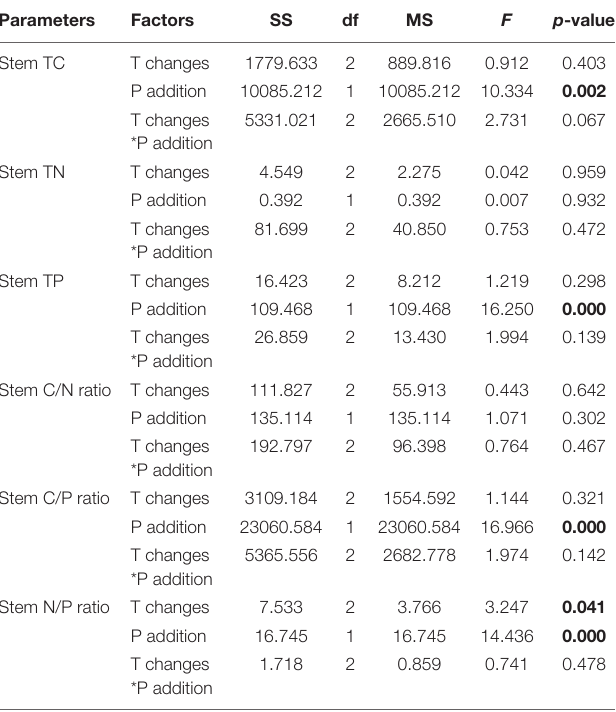
TABLE 2 | Effects of different temperature scenarios and phosphorus addition on the TC, TN, and TP contents and the C/N, C/P, and N/P ratios in P. crispus stems.